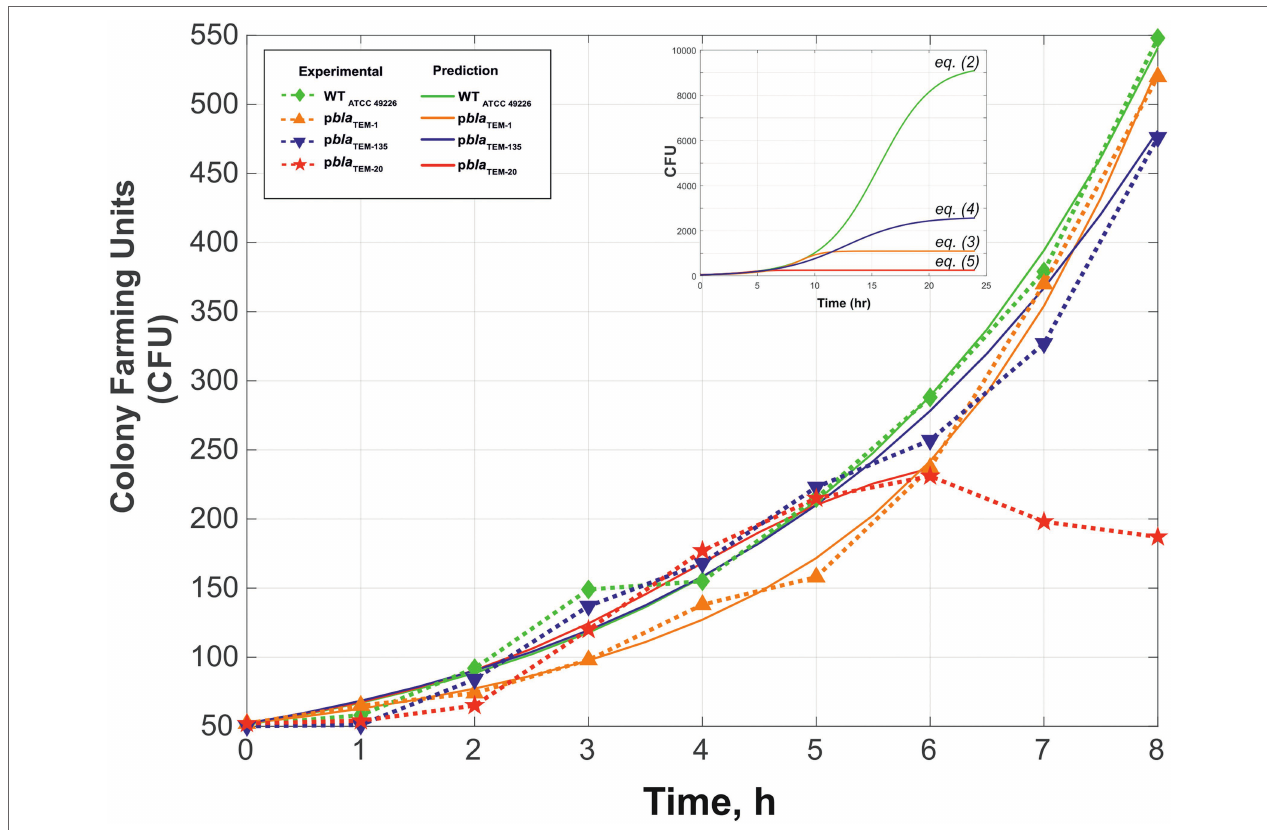
FIGURE 2 | Growth curves (change in CFU over time) of Neisseria gonorrhoeae strain ATCC 49226 not carrying plasmids (WT) and carrying p bla TEM plasmids, in the absence of antimicrobials (37 ° C, 5% CO 2 ). The experimental results are indicated by the dashed lines and dots, and the theoretical curves constructed using Eqs. (2)–(5) are indicated by the solid lines. The inset shows the theoretical curves for incubation periods of up to 24 h to reach N asymp . In the graphs, the dots correspond to the mean CFU from three independent experiments (the initial CFU and the standard deviations are provided in Supplementary Table S1